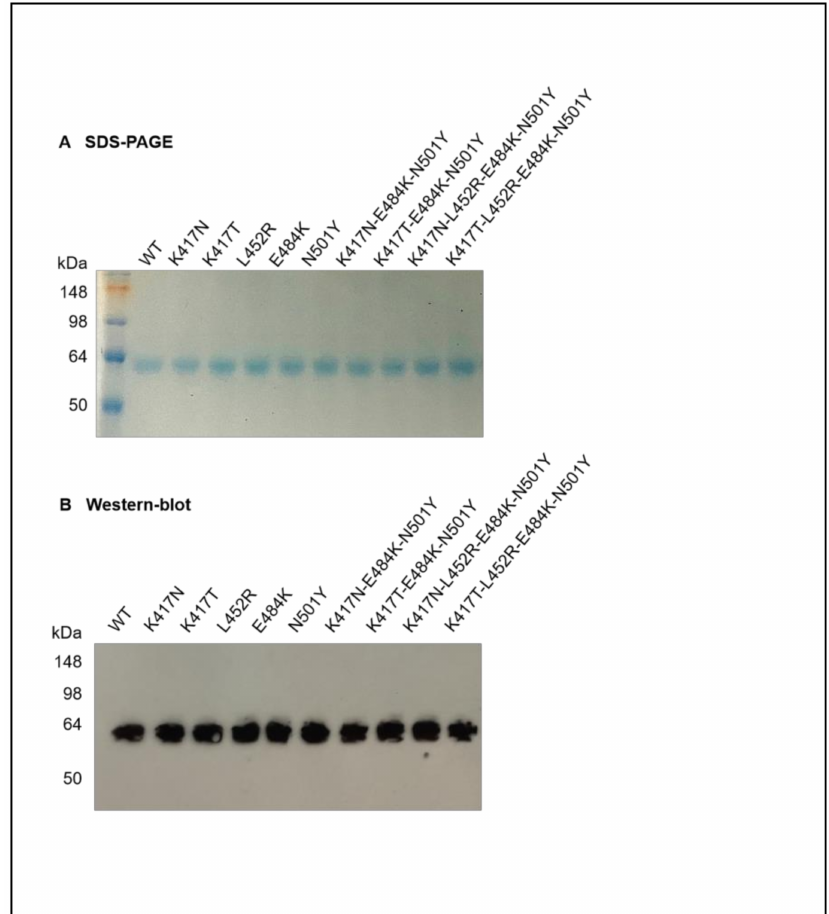
Figure 1. Characterization of recombinant mutant RBD-Fc proteins of SARS-CoV-2. Nine mutant RBD-Fc proteins and wild-type RBD-Fc protein were expressed in 239T cells and purified from the cell culture supernatants. Each protein was then subjected to SDS-PAGE for Coomassie brilliant blue staining ( A ) and for Western blot ( B ) with the sera of mice immunized by wild-type RBD protein without the Fc fragment of human IgG. WT: wild-type RBD-Fc